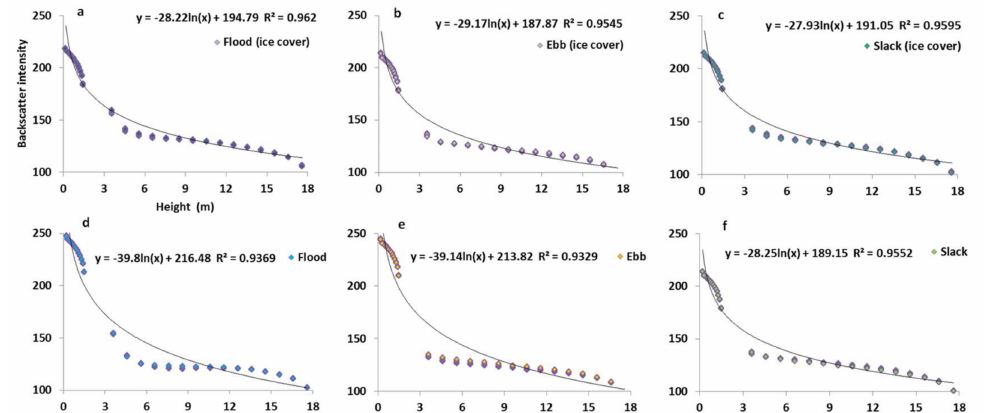
Figure 11. Scatter plots and fitting relations of current velocity at di ff erent heights from the bottom in di ff erent tidal phases during typical spring tide periods: ( a ) the flood tide period with ice cover on February 2; ( b ) the ebb tide period with ice cover on February 2; ( c ) the slack water period with ice cover on February 3; ( d ) the flood tide period without ice cover on February 17; ( e ) the ebb tide period without ice cover on February 18; ( f ) the slack water period without ice cover on February